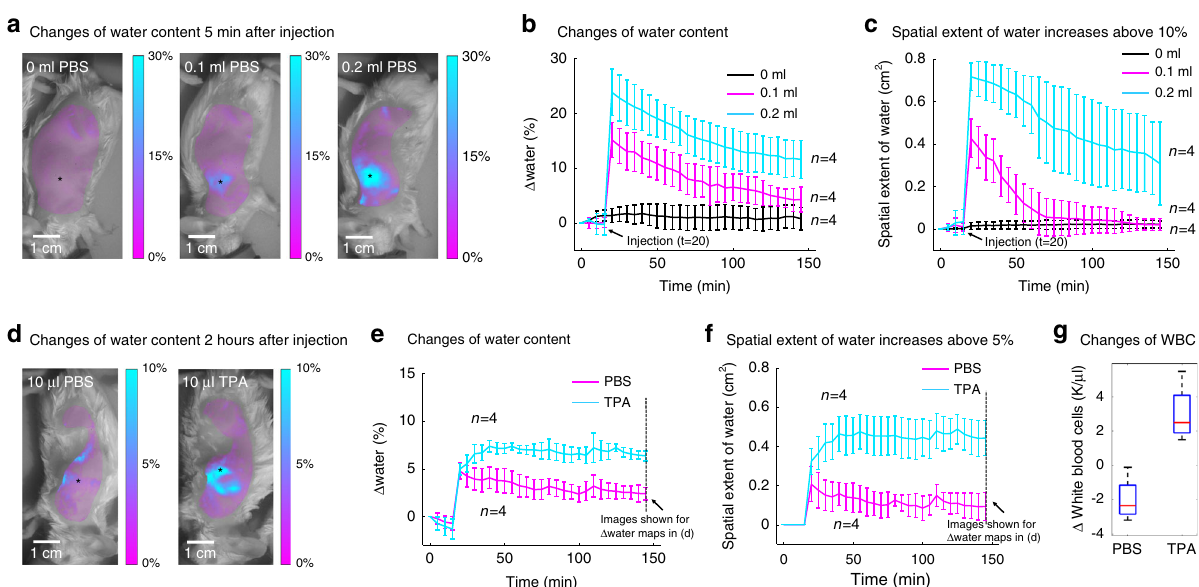
Fig. 2 Non-invasive monitoring of tissue water content in an in vivo model of edema and acute in fl ammation. a Bolus injections of PBS were given subcutaneously to BALB/c mice at three dosages ( n = 4 mice per group). Representative mice are shown 5 min after injection. The injection site is indicated by an asterisk. b Time series of mean water changes for each group (error bars indicate standard deviations). For the 0.1 ml and 0.2 ml groups, signi fi cant water changes were observed after the injection ( p = 0.001 and p = 0.004, respectively). c Time series of mean spatial extent of water content increases. For the 0.1 ml and 0.2 ml groups, signi fi cant changes in spatial extent were observed after the injection ( p = 0.003 and p < 1e-3, respectively). d Bolus injections of 10 µ l PBS (control) or 10 µ l TPA (pro-in fl ammatory) were given subcutaneously in two groups of mice ( n = 4 mice per group). Changes in water content are shown 2 h after injection. A sustained increase of water content was observed in the TPA group. e Time series of changes in tissue water. For the 10 µ l PBS group, the water content gradually decreased after the initial injection. For the 10 µ l TPA group, water content increased for up to 30 min after injection, consistent with the presence of edema caused by in fl ammation, which was con fi rmed by histologic visualization of resected tissue. At 145 min, the water content of the TPA group remained elevated and signi fi cantly different from the control (PBS) group ( p < 1e-4). f Time series of mean spatial extent of water content increases. At 145 min, the TPA group remained elevated and signi fi cantly different from the control (PBS) group ( p < 1e-3). g The TPA group showed a signi fi cant increase in white blood cell count (WBCs) compared with the control group ( p = 0.004) at 5 h after injection, indicating in fl ammation. A small decrease in WBCs was observed in the PBS group, consistent with previous measurements in mice under anesthesia 74 . Source data are provided as a Source Data fi Fig. 3e. The choice of ROI was blinded from SWIR-MPI lipid maps. A Pearson correlation coef fi cient of 0.74 ( p < 1e-5) was